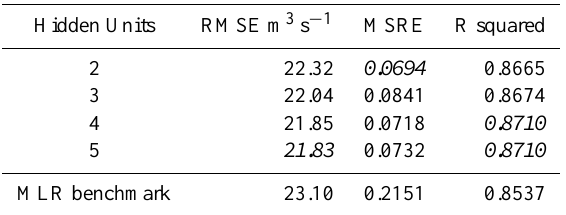
Table 6. Validation performance of candidate models for Scenario B. Best performing ANN models for each metric are in